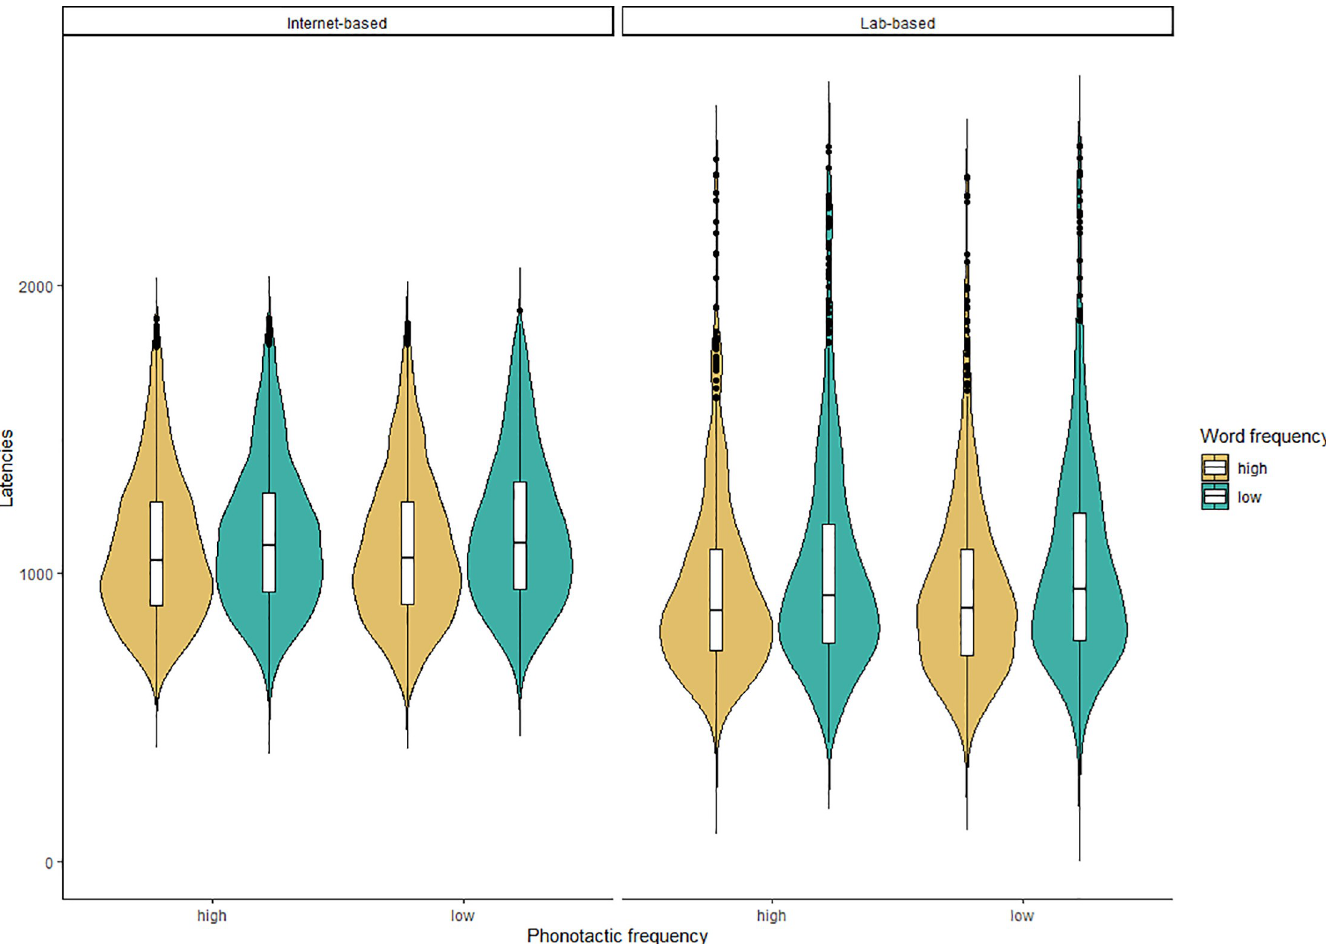
Fig 2. Naming latency distributions across experiments. Latencies for the internet-based experiment (left panel) and the lab-based experiment (right panel), by word frequency (high: yellow, low: green) and phonotactic frequency (within each panel, high: left, low: right).